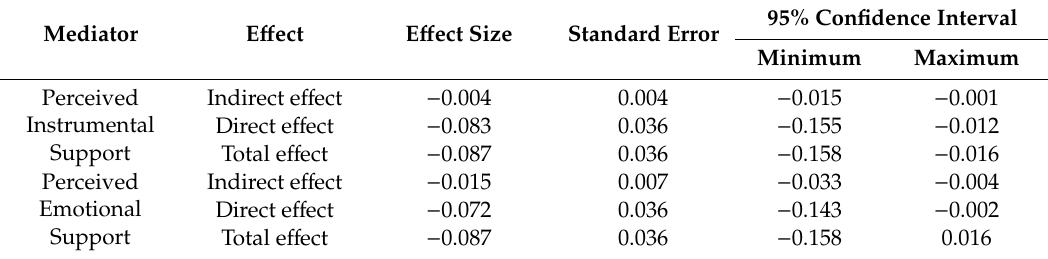
Table 4. Bootstrapping tests for the mediating e ff